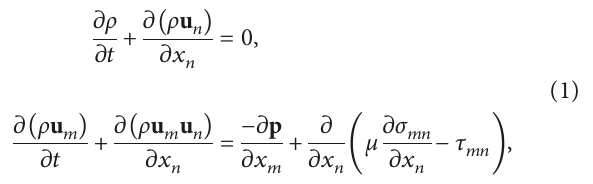
Figure 2: Schematic diagram of the flexible fiber